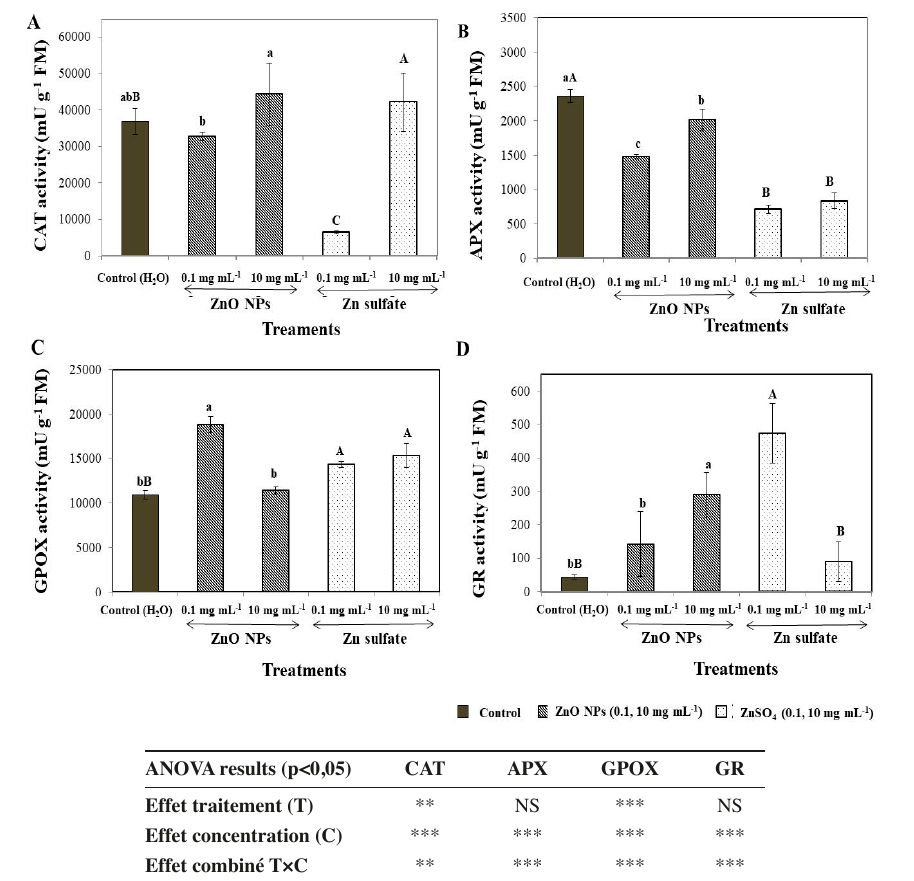
Fig. 6: Activities of the antioxidant enzymes CAT (A) , APX (B) , GPOX (C) and GR (D) in the embryonic axes of Lathyrus sativa L. seeds germinated for 4 days in the presence of distilled water (Control) or solutions of ZnO NPs and ZnSO 4 at concentrations of 0.1 mg ml -1 and 10 mg ml -1 . Values are means (±SD) of 5 independent measurements. Letters a-c and A-C denote statistic classes, respectively, for ZnO NP and Zn sulfate, using Duncan test (α=0.05). Differences are significative, at *: 0.01≤P<0.05, **: 0.001≤P<0.01, ***: P<0.001, and non significant NS at P≥0.05.